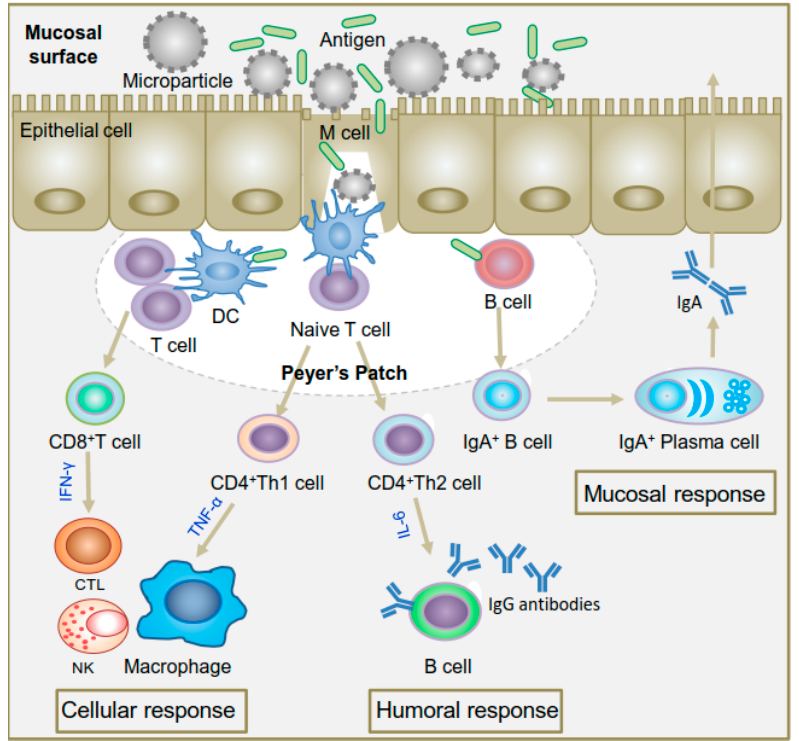
Figure 3. Schematic diagram of various immune responses induced by particulate vaccine system. Upon encounter with an antigen, B cells convert themselves to antibody secreting plasma cells that produce antibodies for excreting the pathogens to mucosal surfaces (mucosal response) whereas dendritic cells (DCs) present the antigen via major histocompatibility complex (MHC) class I and class II molecules to CD8+ and CD4+ T-cells. Activation pathway of CD8+ T cells and CD4+ Th1 cells produces cytotoxic T lymphocytes (CTL) and activated macrophages that kill intracellular pathogens or infected cells (cellular response) while activation pathway of CD4+ Th2 cells produces activated B lymphocytes that secrete antibodies for neutralization of extracellular pathogens (humoral response) (Reprinted with permission from Ref. [6]).